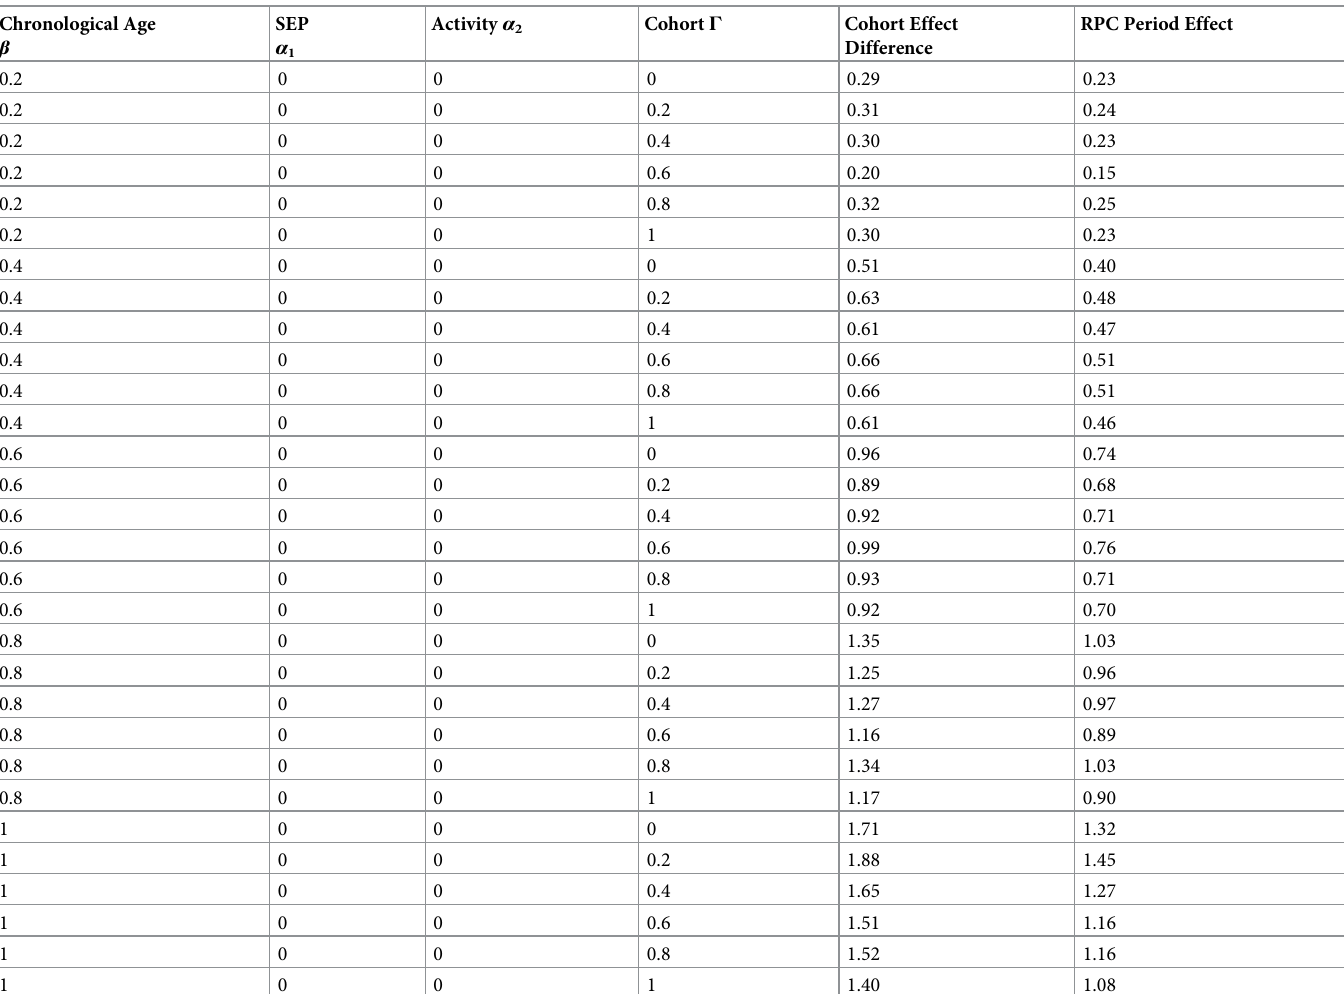
Table 3. Problematic slope parameter patterns in simulation study